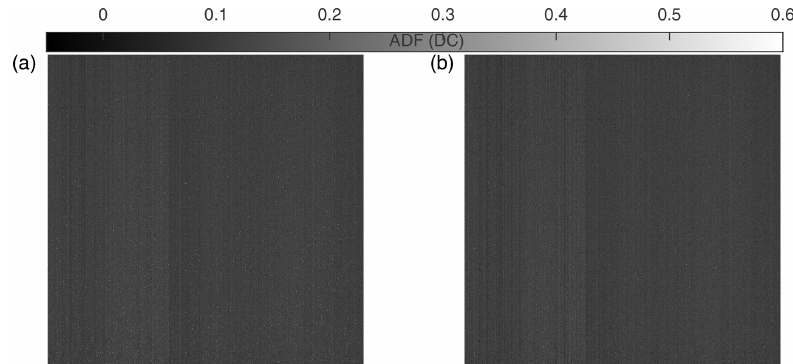
Figure 4. Averaged dark frame with (a) and without (b) hot pixels.